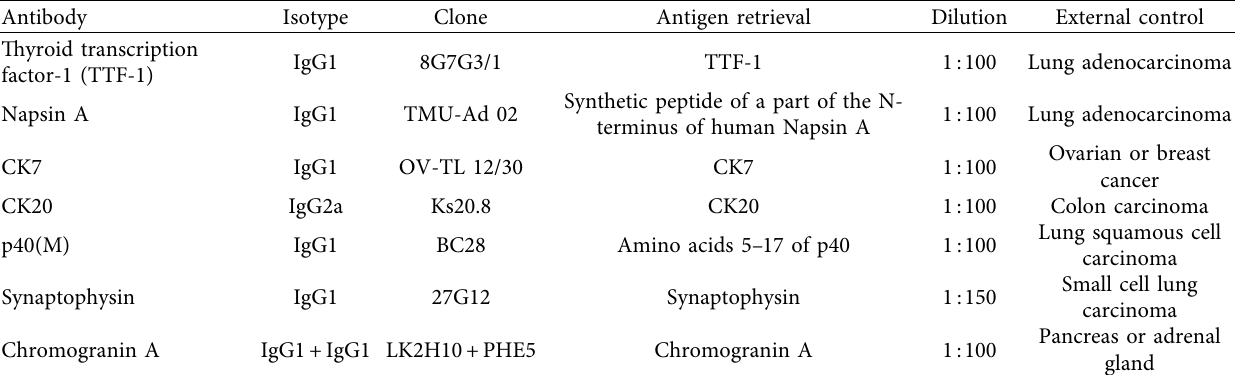
Figure 3: Microscopical features of (a) lung tumor composed of malignant cells, predominantly arranged in an alveolar growth pattern, defined by solid sheets and tumor nests (H&E, 40X); (c) gastric mucosal lesion-malignant epithelial proliferation with adenocarcinoma morphology (H&E, 100X); (b) renal lesion; and (d) adrenal lesion-malignant epithelial proliferation with cytological and architectural modifications like that found in the lungs, presenting with massive alveolar growth pattern and extensive foci of necrosis (H&E, 40X). Table 1: Antibodies used for immunohistochemical